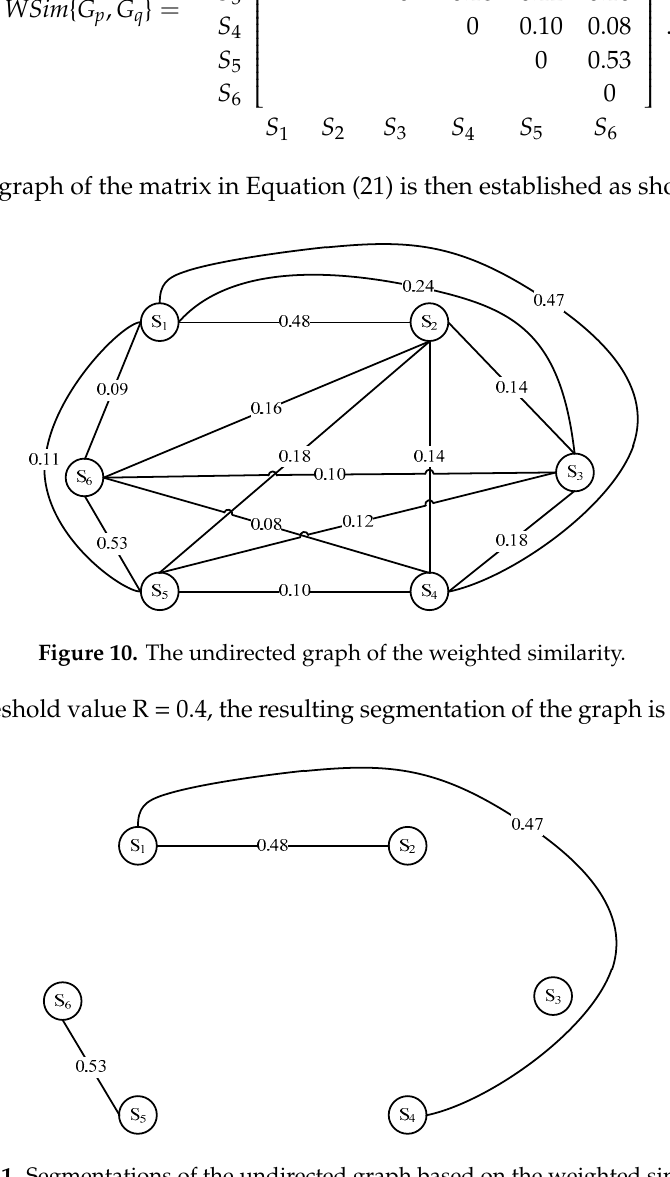
Figure 11. Segmentations of the undirected graph based on the weighted similarity.